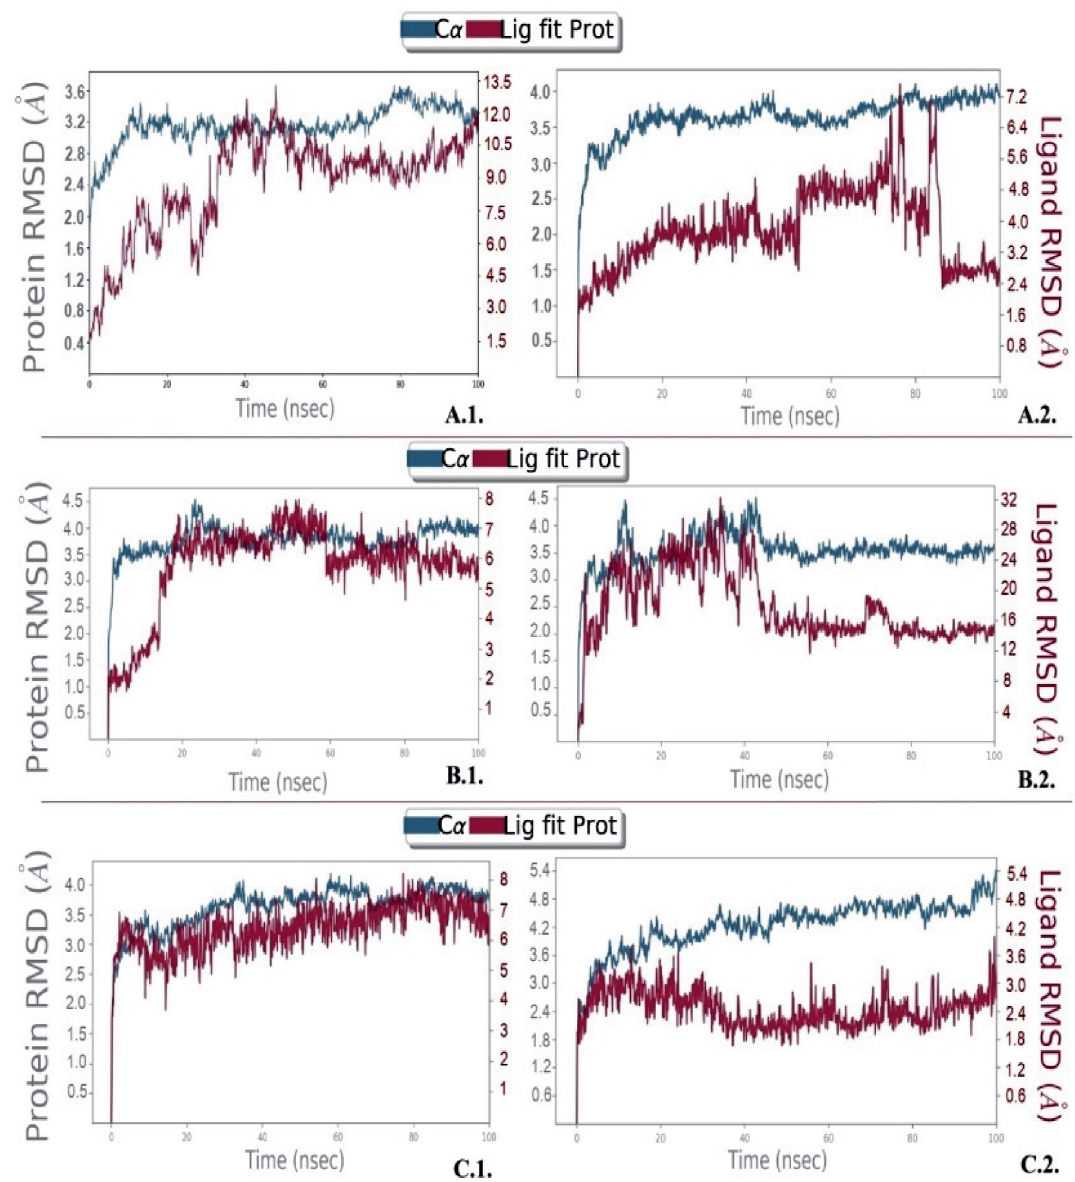
Figure 7: Desmond MD calculated Protein and Ligand RMSD: A.1.: OCT-1 and Metformin, A.2.: OCT-1 and Phenformin, B.1.: OCT-2 and Met- formin, B.2.: OCT-2 and Phenformin, C.1.: OCT-3 and Metformin and C.2: OCT-3 and